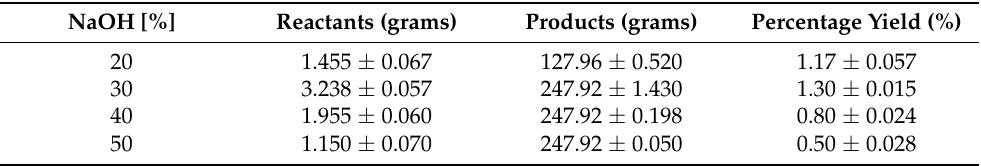
Figure 1. ( A ) Chitosan (chi) and optimization product of synthesizing chitosan-spheres (chi-spheres) using ( B ) 20%; ( C ) 30%; ( D ) 40%; ( E ) 50% NaOH. Table 1. Percent yield of chi-spheres using various concentrations of NaOH. The preparation of chi-spheres was performed in duplicates.